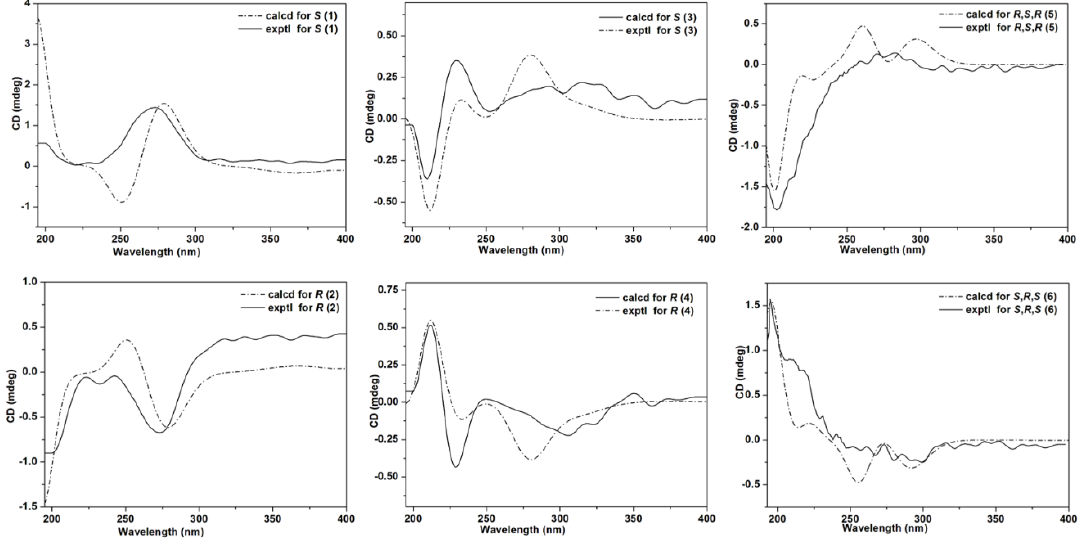
Figure 3. Experimental and calculated ECD spectra for 1 – 6 .